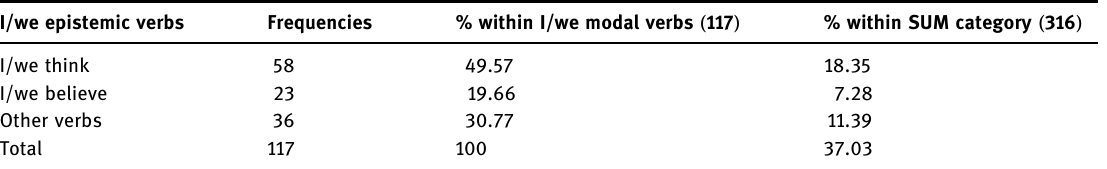
Table 8: Frequencies and percentages of the most frequent I/we epistemic verbs in the whole corpus I/we epistemic verbs